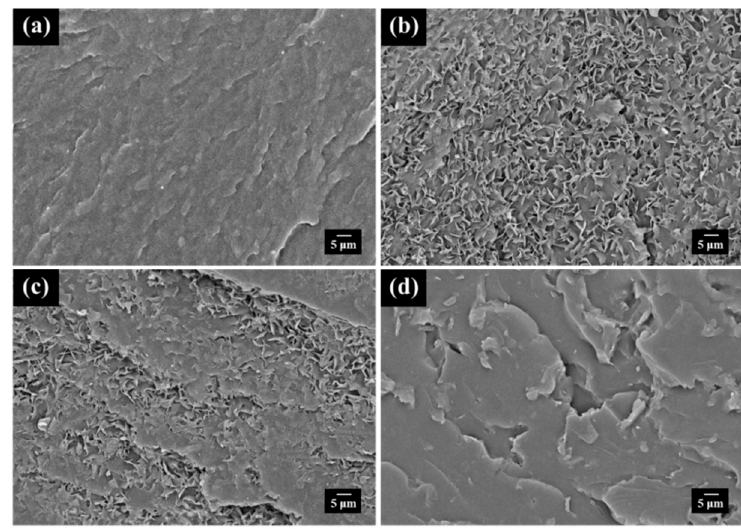
Figure 7. SEM micrographs of fracture surfaces of ( a ) DA-PEBF-0, ( b ) DA-PEBF-1, ( c ) DA-PEBF-2, and ( d ) DA-PEBF-5, respectively.